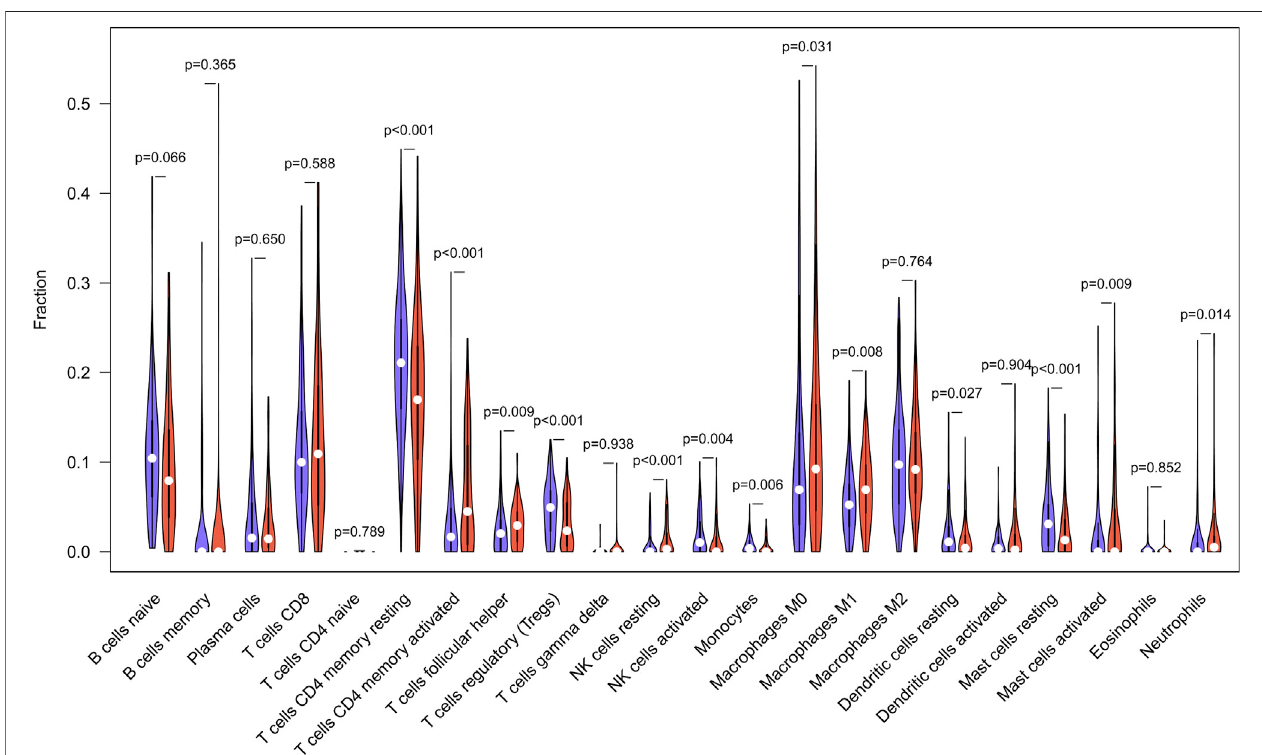
FIGURE 5 | TMB and immune markers in STAD were found to be correlated. In high (red violin part) and low (blue violin part) TMB groups, there are 22 types of adaptive and innate immune cells (by wilcox test).